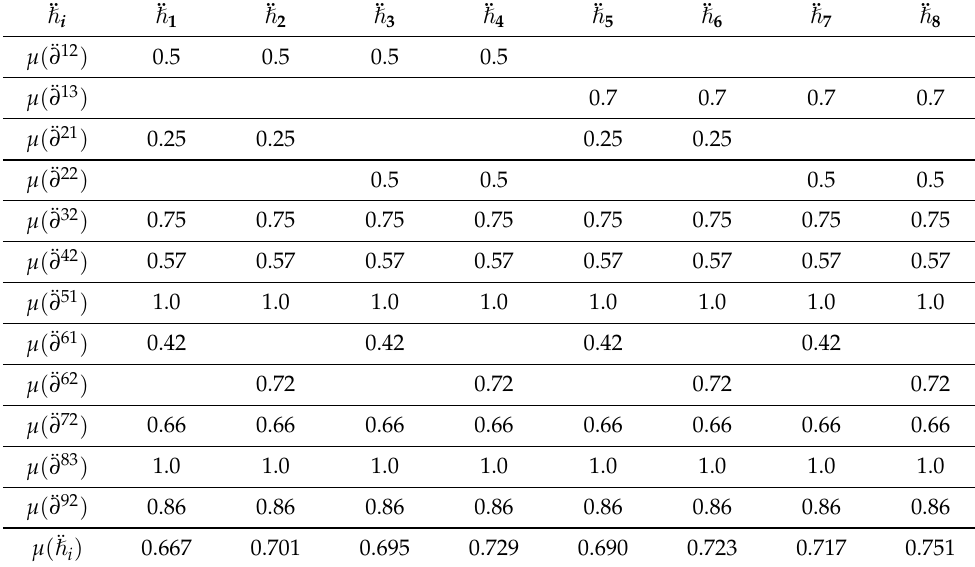
Table 5. Fuzzy membership corresponding to each ¨ (cid:125) i .